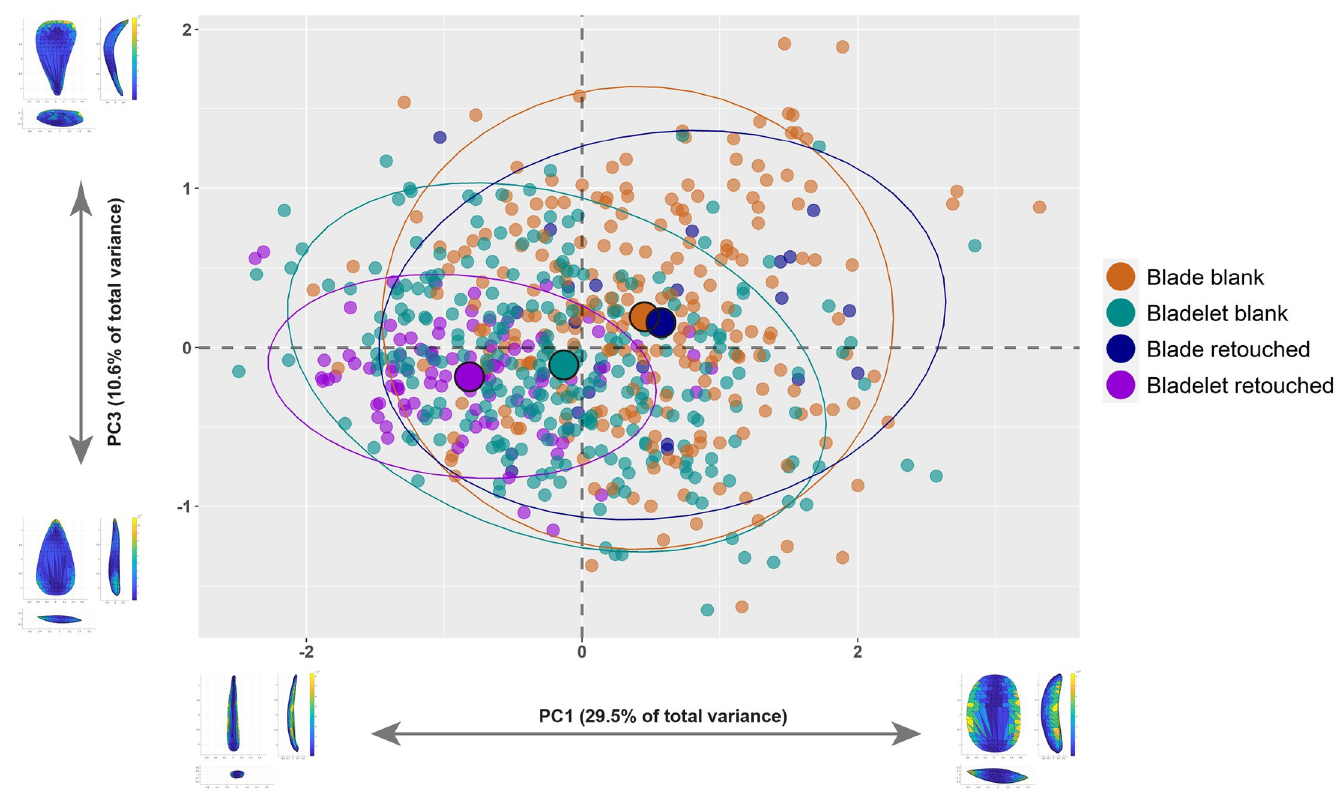
Fig 2. Bivariate plot of the first and third principal components (PC1 versus PC3). The illustrations in the x and y axes of the plot describe the variation of hypothetical shapes of blanks situated at the extremes of each principal component. Illustrations were created with the Warp tool in AGMT3-D ). The mean of each group in the plot are identified with bigger dots. 95% confidence ellipses are plotted. For colors see the